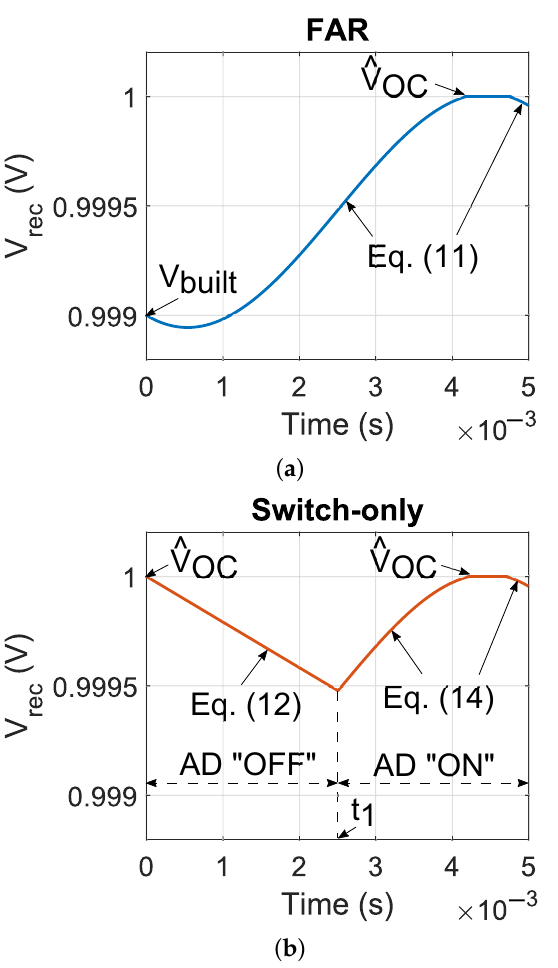
Figure 7. Simulated transient evolution of V rec ( t ) on half a period if I peh ( a ) FAR, ( b ) Switch-only. The parameters are C peh = 100nF; C L = 100µF; R L = 48k Ω ; ω = 200 π rad/s; and I peh = 20 π e − 6